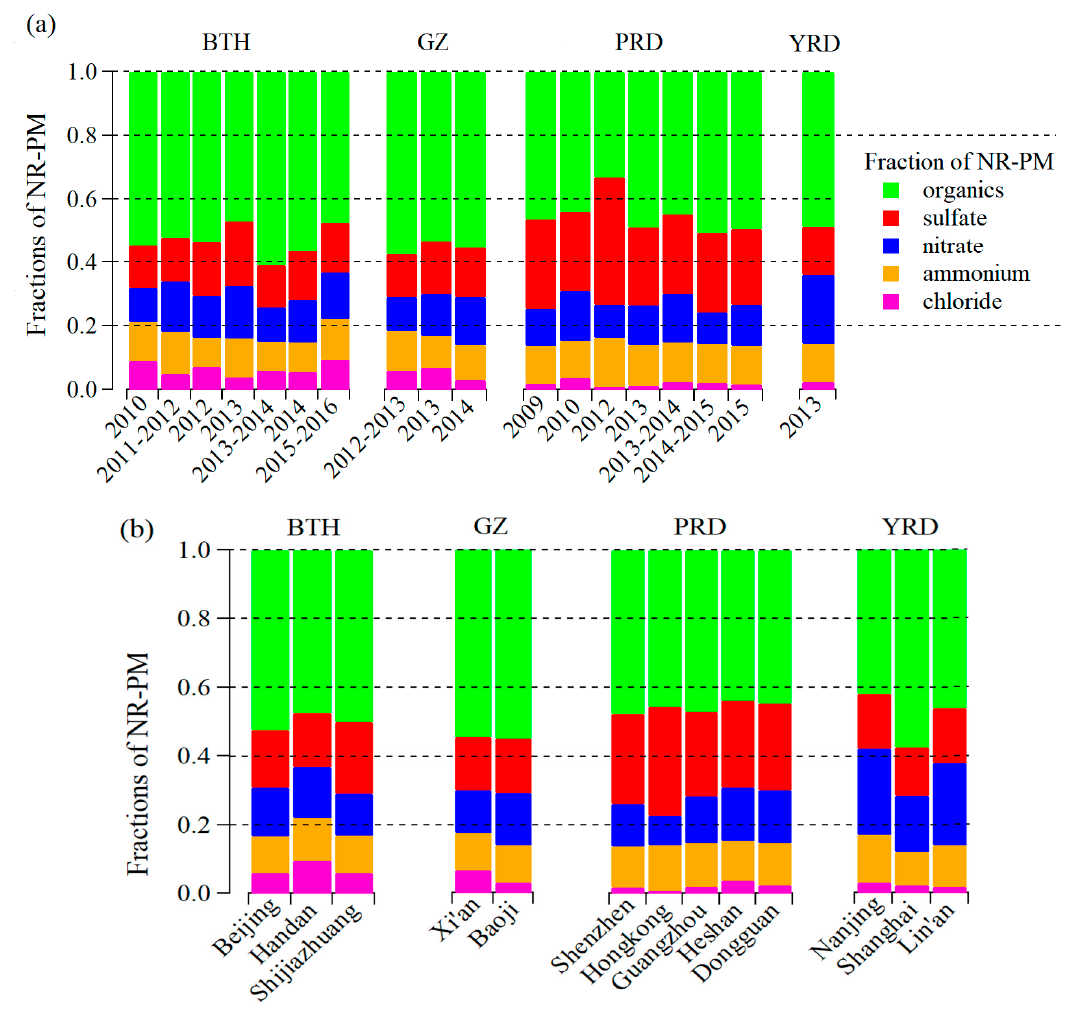
Figure 3. Relative composition of the non-refractory PM in ( a ) di ff erent years and ( b ) across the four regions.